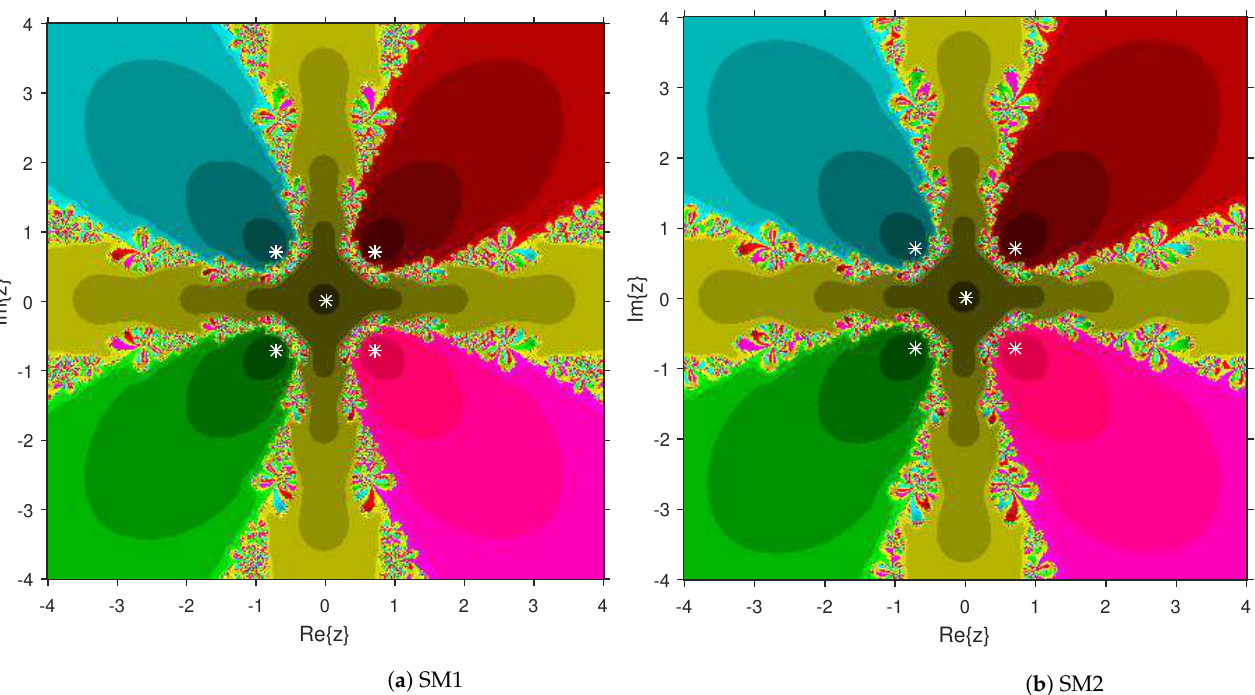
Figure 7. Attraction basins comparison between SM1 and SM2 related to M 7 ( z ) .